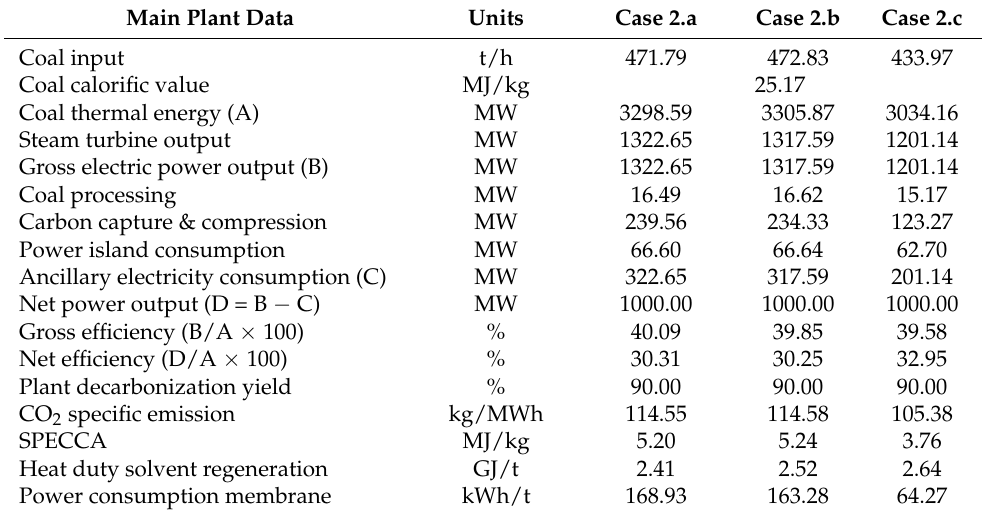
Table 3. Global plant performance indexes of hybrid cases.